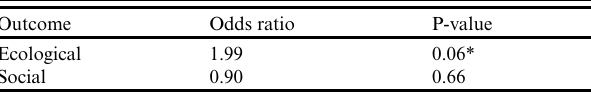
Table 4 . The results of Fisher’s exact tests for overall ecological and social outcomes excluding non-conclusive outcomes. The odds ratio is the odds of getting negative outcomes compared to the positive outcomes. * Outcomes are statistically significant at p < or = 0.1